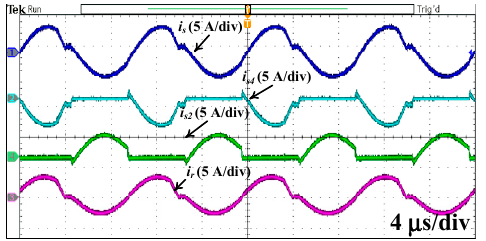
Figure 10. D Vgs5 = 0.9, R L = 100 ohm, Vo = 390 V, f s = 100 kHz.